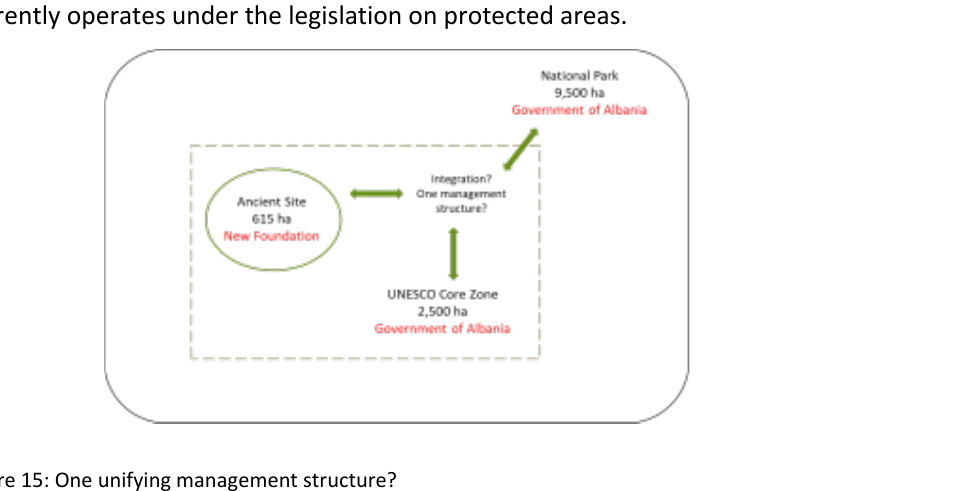
Figure 15: One unifying management